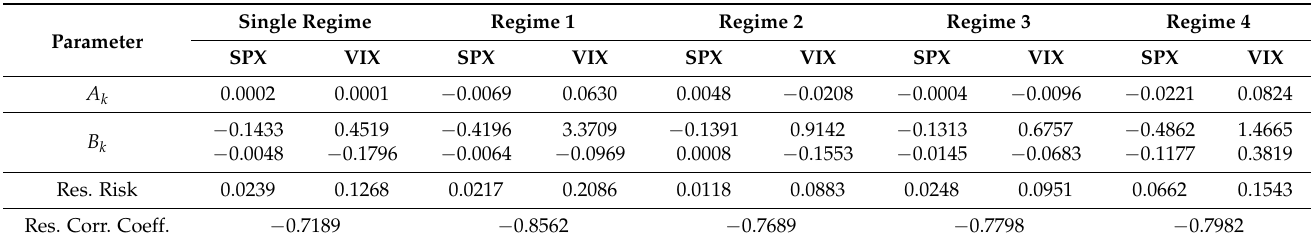
Table 3. Coefficient estimates for SPX and VIX in model (1) by regime (31 December